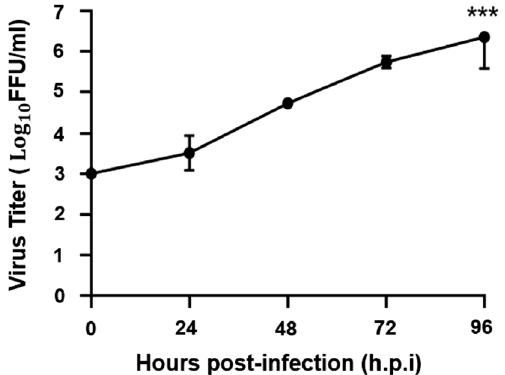
Figure 1. Replication kinetics of ZIKV in Huh7 cells. Huh7 cells were infected at a multiplicity of infection (MOI) of 1 in 96-well plate and the replication of virus was studied after 1–4 days post-infection (p.i).